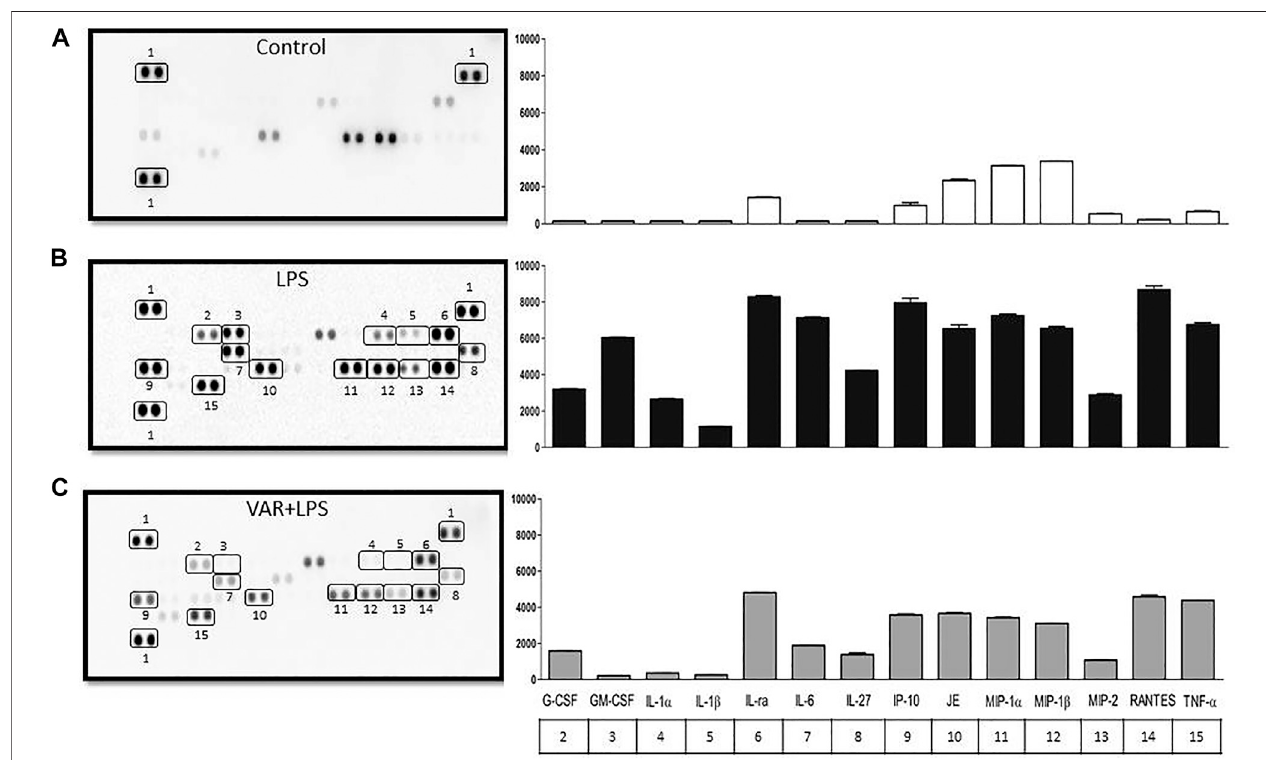
FIGURE 2 | EffectsofvareniclineonLPS-inducedcytokinelevelsinRAW264.7macrophages.Shownaremembrane-basedantibodyarraysof14mousecytokinesfound insupernatantsofthecontrolgroup (A) ,4 μ g/mlLPS-induced (B) andLPS-inducedmacrophagesinthepresenceof1 µMvarenicline(VAR) (C) .Eachsampledotcorrespondsto aspeci fi ccytokinereleasedfromthesamecellpopulationusedinotherexperiments(pooleddata, n (cid:1) 5 – 7).Bargraphicsshowaveragedpixelintensitiesofeachdotinduplicate. The table below the right panel shows the numerical annotations of the relevant cytokines detected in the left membranes (1: reference